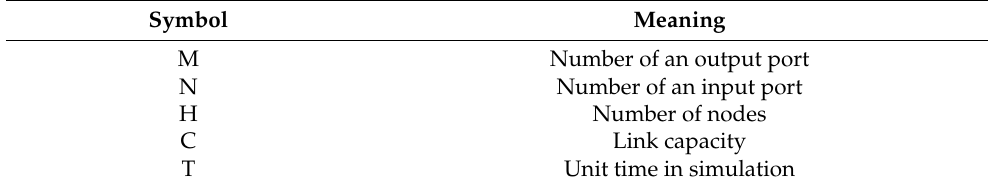
Table 2. Symbols used in topology description.